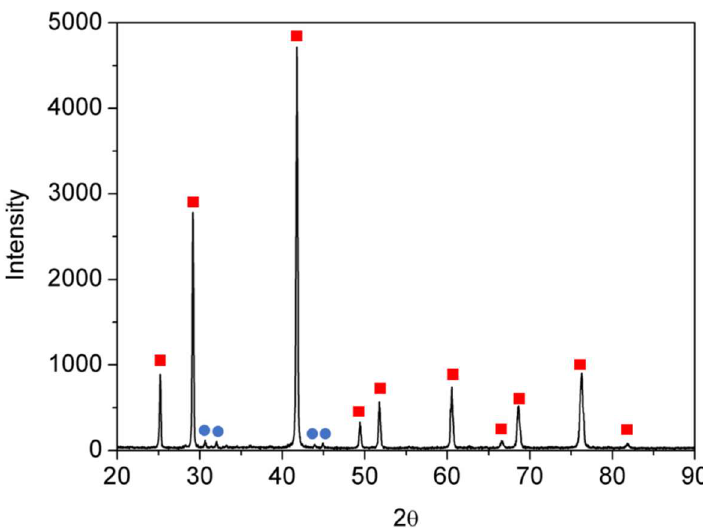
Figure 2. X-ray diffractogram (XRD) spectra of the synthesized sample. Red squares indicate the HH Figure 2. X-ray di ff ractogram (XRD) spectra of the synthesized sample. Red squares indicate the HH phase and the blue circles, the minority Sn phase. phase and the blue circles, the minority Sn